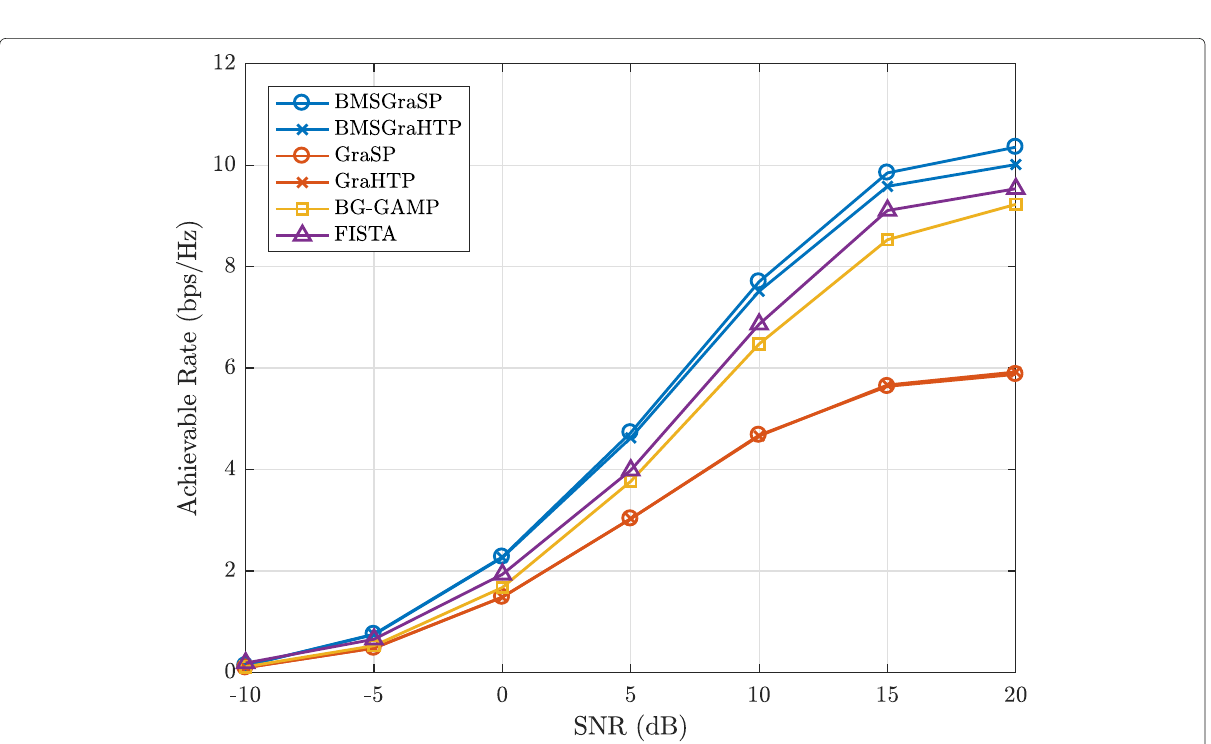
Fig. 7 Achievable rate lower bound [15] vs. SNR where M = N = 64, T = 80, and L = 4 with varying B RX and B TX from algorithm to